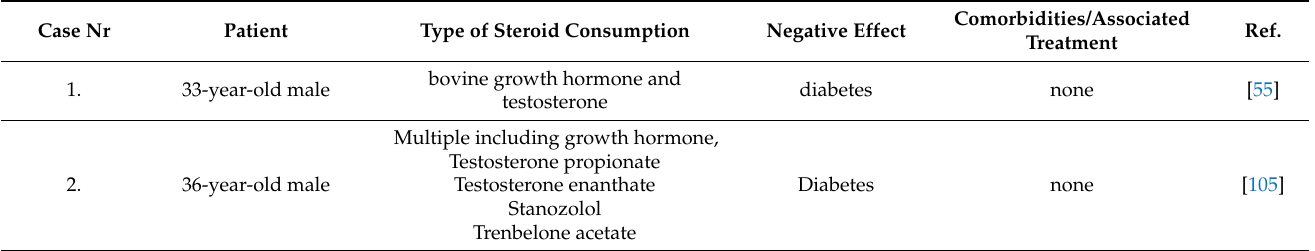
Table 6. Cases of diabetes presenting after consumption of AAS and growth